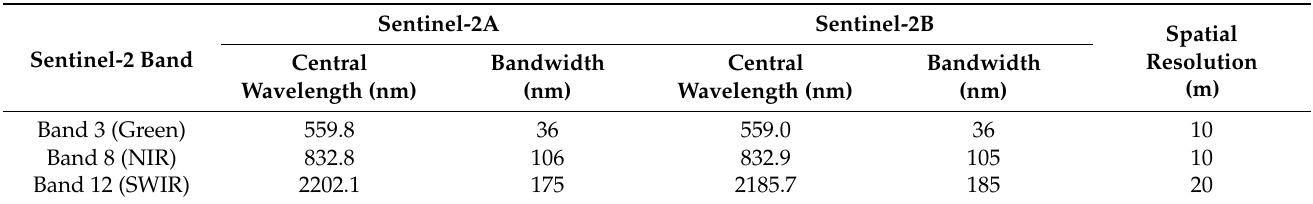
Figure 5. The process of water body detection using Sentinel-2 imageries. Table 2. The spectral bands and spatial resolution of the Sentinel-2 sensors used for the NDWI calculation.